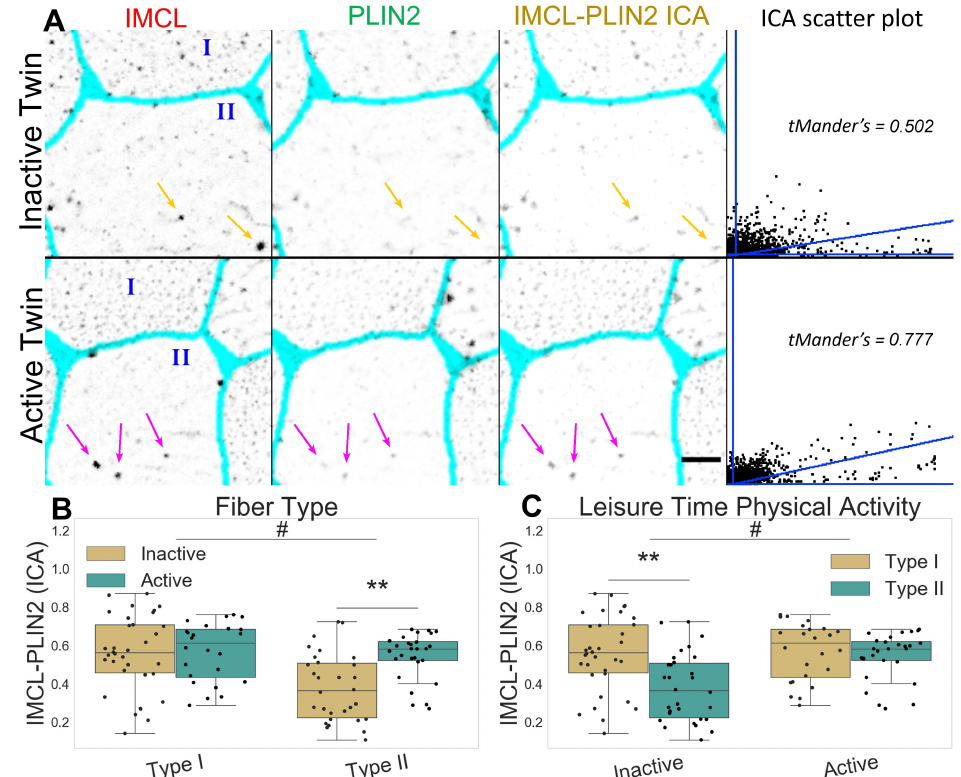
Figure 3. IMCL-PLIN2 intensity correlation analysis in twin pairs. ( A ) representative image showing differences between groups. Gray level indicates marker signal, cyan indicates segmented sar- colemma. Note active twin type II fiber with high intensity IMCL significantly colocalized by PLIN2 (magenta arrows), unlike the inactive twin (orange arrows). Bar = 10 µm. Scatter plot is relative to the arrowed type II fiber; ( B ) fiber type as main effect, with LTPA combined; ( C ) LTPA as main effect, with fiber type combined, main effect differences denoted with # ( p < 0.01); combined group differences denoted with ** ( p < 0.001). Dots in ( B , C ) represent individual